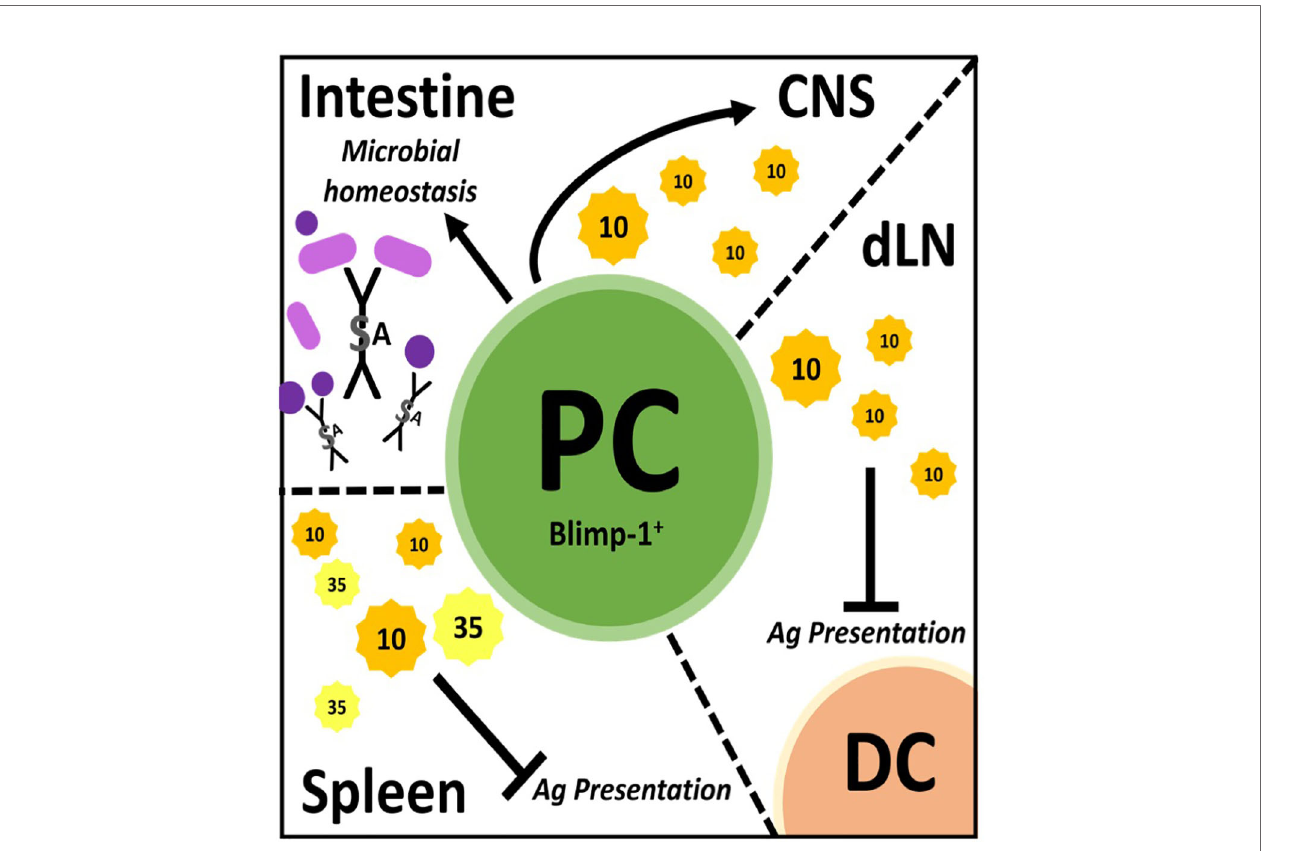
FIGURE 1 | Plasmablast/plasma cells (PC) regulate through many mechanisms in different tissues. PC facilitate microbial homeostasis at mucosal surfaces like the small and large intestine through secretion of lgA, a dimerized lg with added features. These PC can migrate to the central nervous system (CNS) and secrete IL-10 to dampen in fl ammation therein. In draining lymph nodes (dLN), PC secrete IL-10 to inhibit antigen (Ag) presentation by dendritic cells (DC), thereby dampening immune responses. PC secrete IL-10 and IL-35 in the spleen which is believed to inhibit Ag presentation